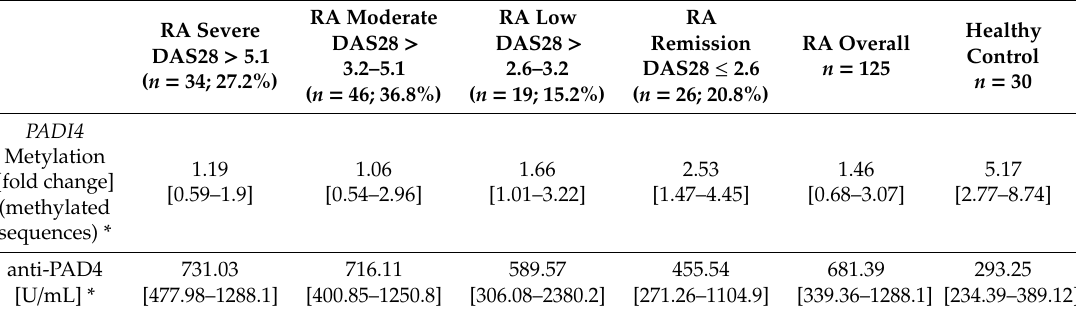
Table 2. The PADI4 promoter methylation degree (methylated sequences) and anti-PAD concentration level in RA group divided according to DAS28, RA patients generally and in healthy control.